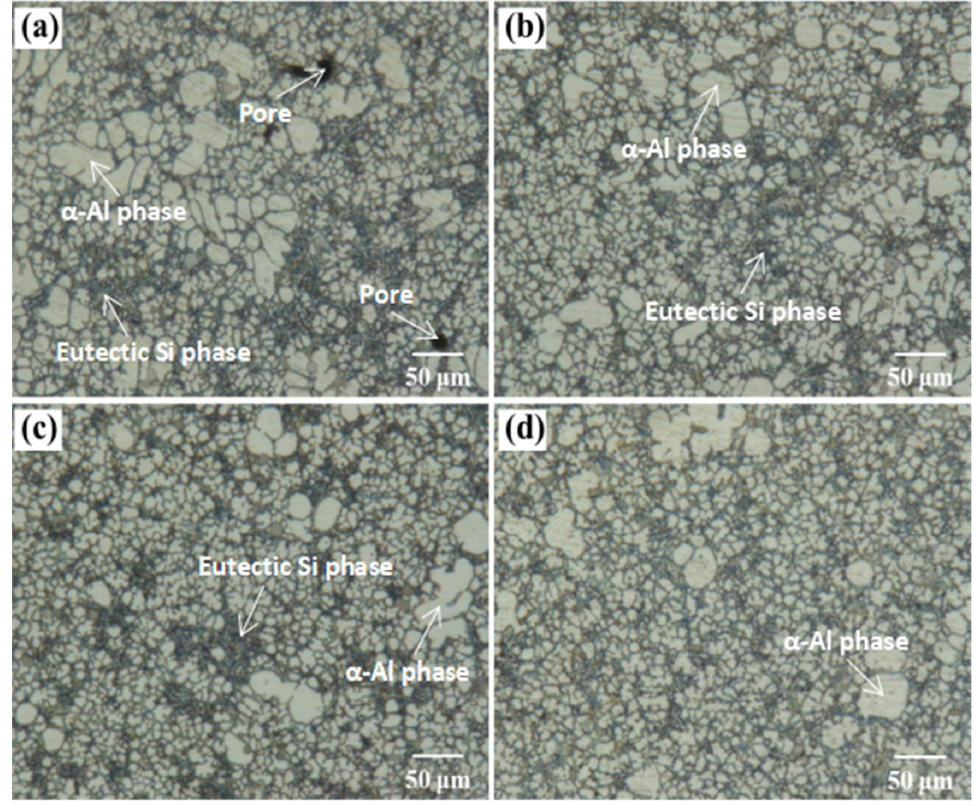
Figure 7. Microstructure of thin-walled area at different injection speeds: ( a ) 3.5 m/s, ( b ) 4.0 m/s, ( c ) 4.5 m/s, ( d ) 5.0 m/s. ( c ) 4.5 m/s, ( d ) 5.0